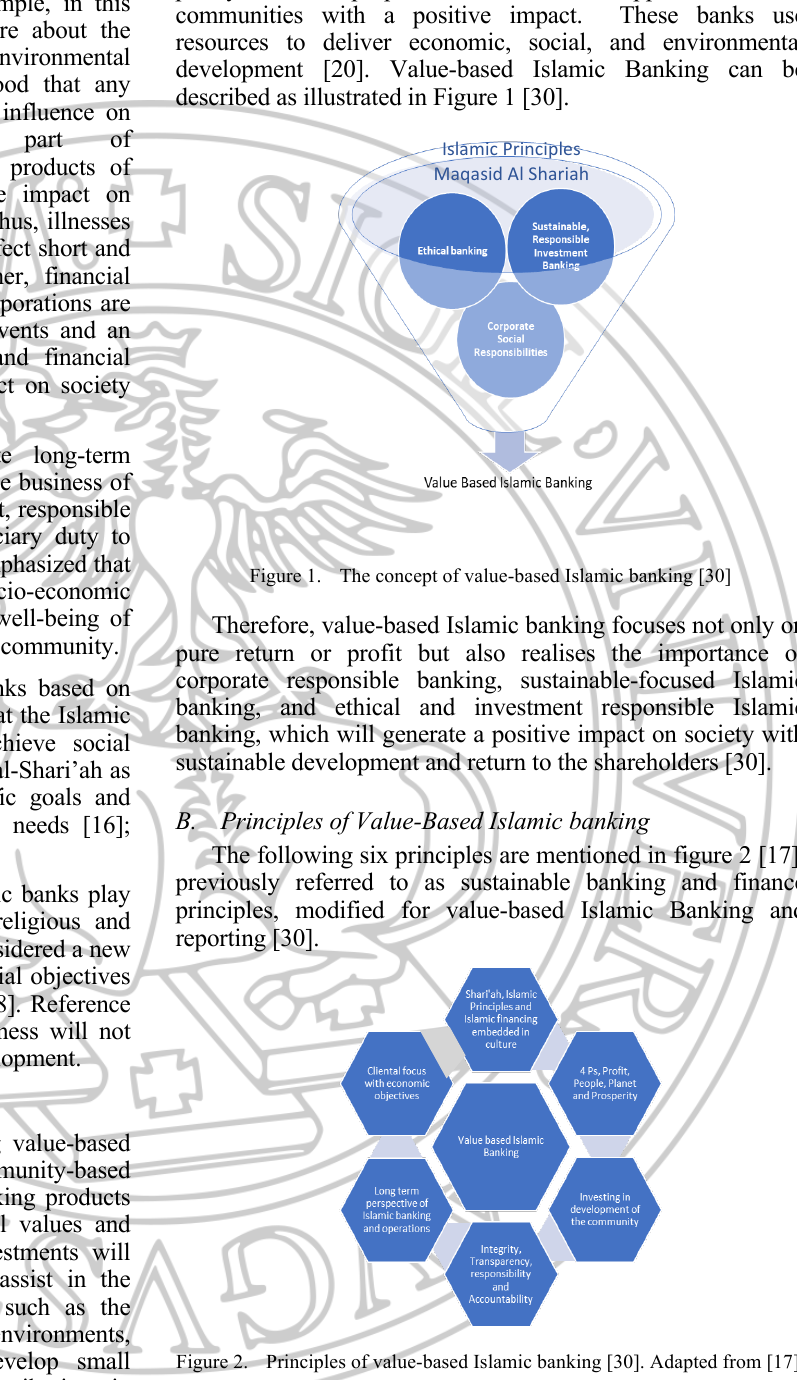
Figure 2. Principles of value-based Islamic banking [30]. Adapted from